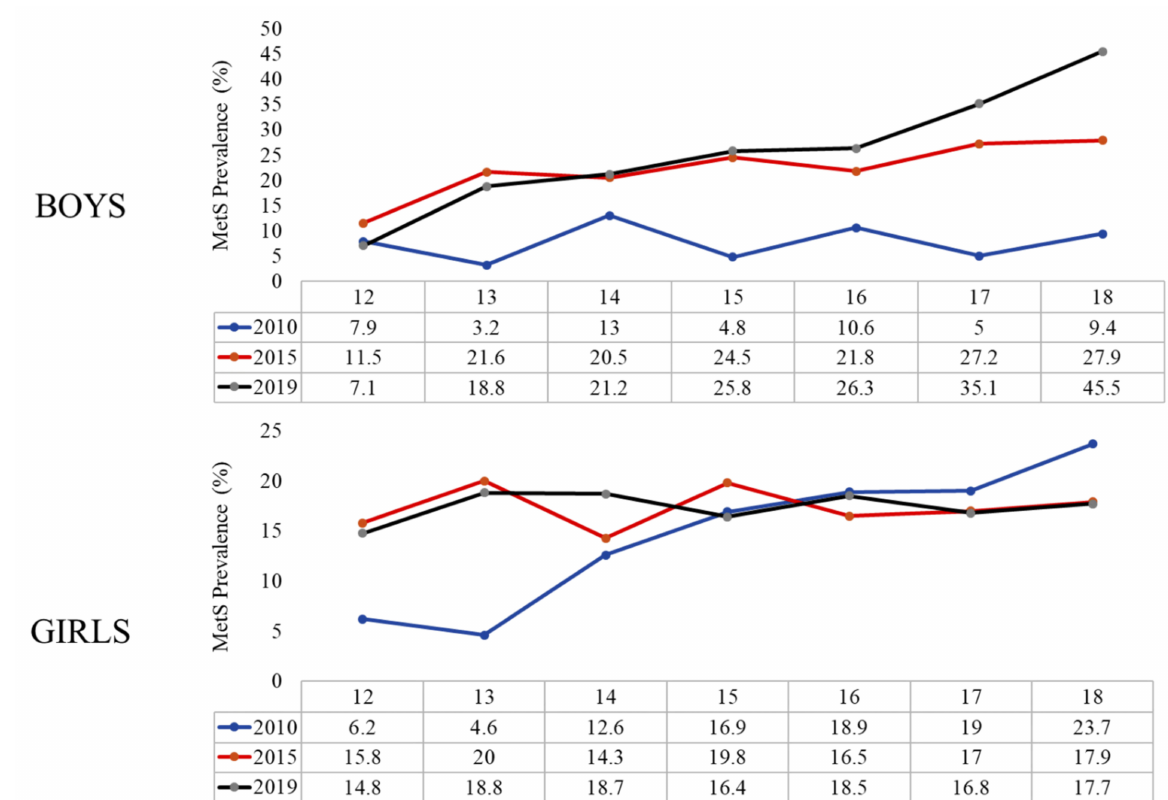
Figure 3. Prevalence of MetS according to the age groups in boys and girls